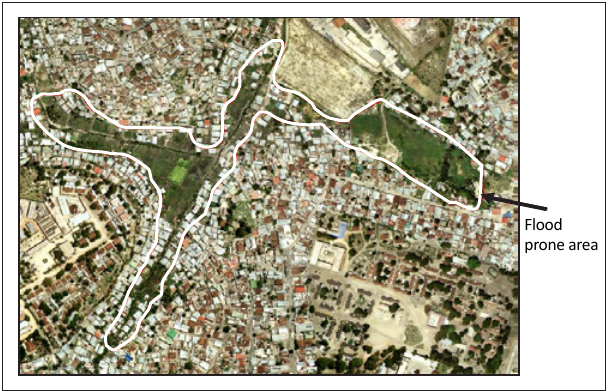
FIGURE 1: Aerial photo showing flood-prone areas.